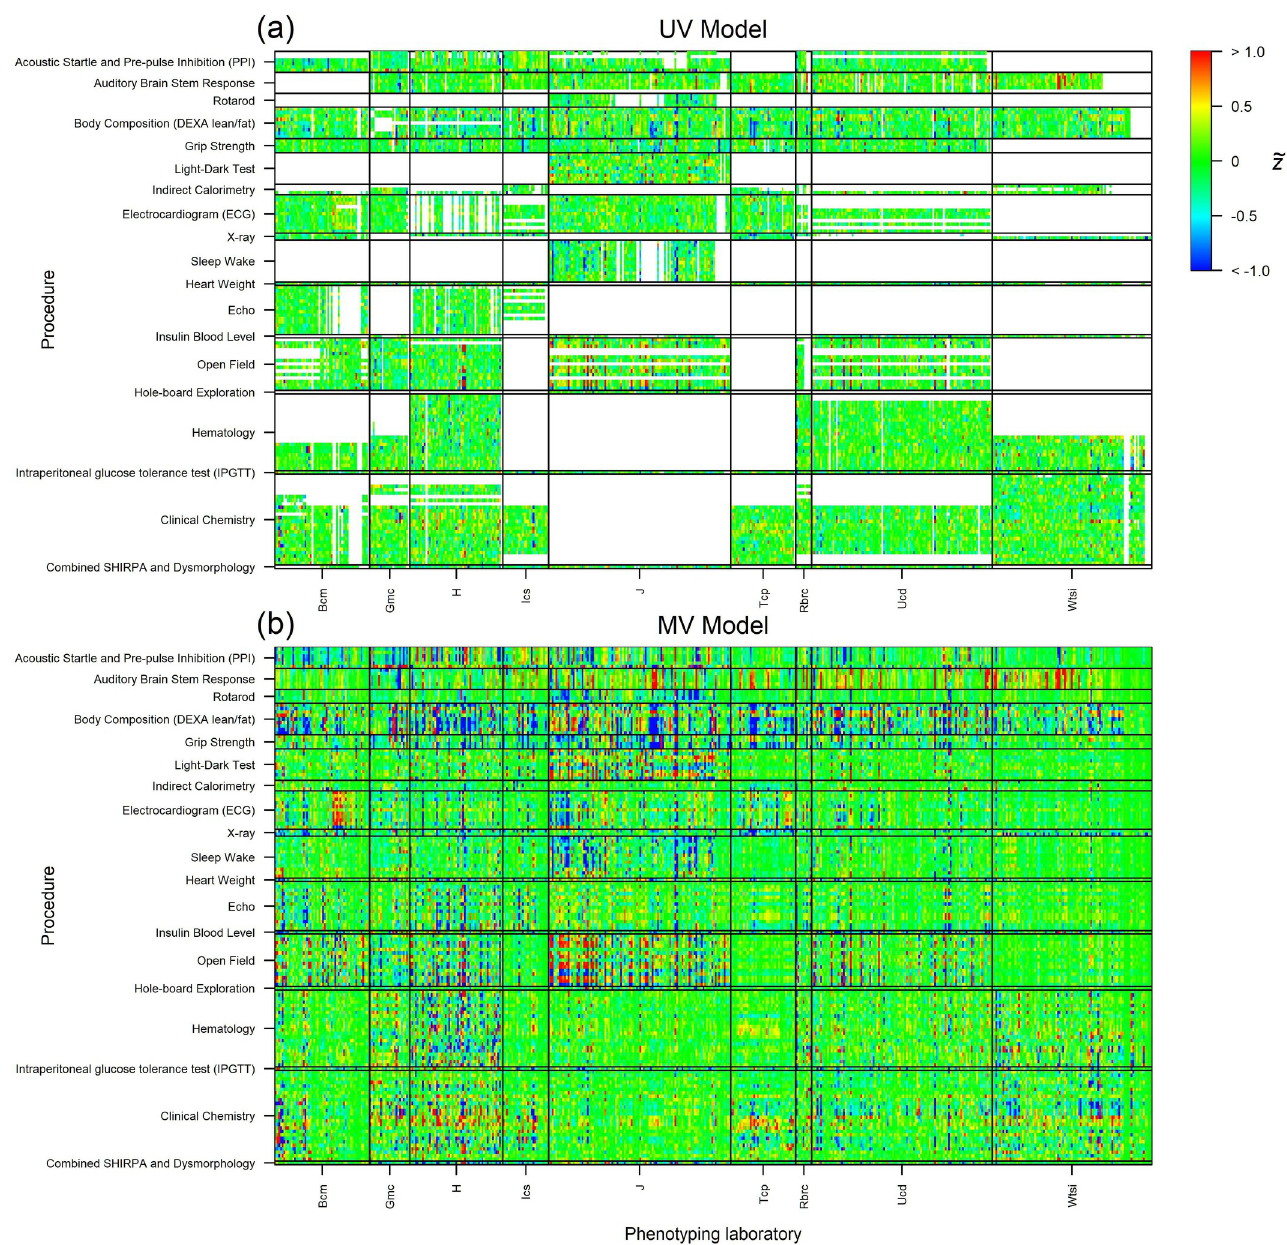
Fig 2. Global representation of increased sensitivity of the MV model. Each row corresponds to a phenotype, with multiple phenotypes grouped by procedure, labelled left. Each column corresponds to a KO line, with multiple lines grouped by phenotyping laboratory, labelled bottom. For effective visualisation, only a random subset of 500 KO lines is shown. The heatmaps display scaled z -statistics, so that e z > 1 and e z < (cid:0) 1 correspond to a gene KO causing a significant increase/decrease respectively in the phenotype (Methods– Control of error rates ). (a) UV model, where white squares indicate missing phenotype data; and (b) MV model. The data and code used to generate this figure are available at [13,14].KO, knockout; MV, multivariate; UV,